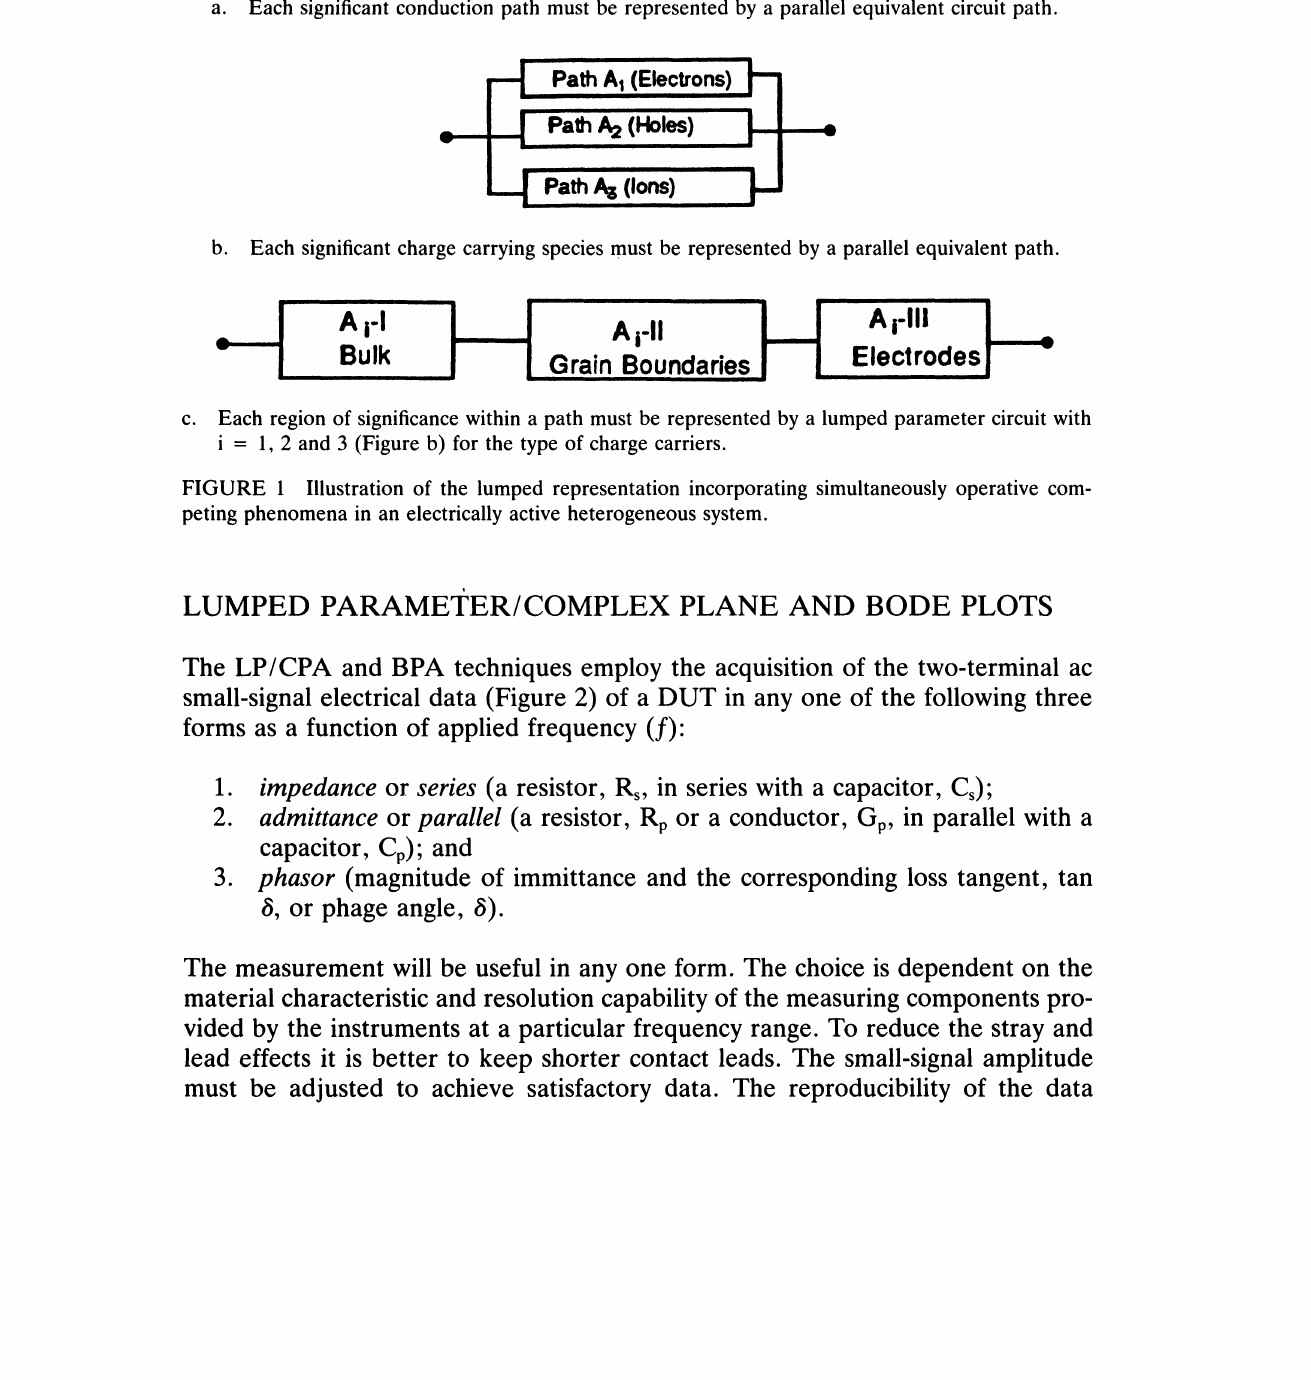
Path, A (Electrons) Path A (Ions) b. Each significant charge carrying species must be represented by a parallel equivalent path. At-I Ai’lll Ai’ll Electrodes Bulk Grain Boundaries c. Each region of significance within a path must be represented by a lumped parameter circuit with 1, 2 and 3 (Figure b) for the type of charge carriers. FIGURE Illustration of the lumped representation incorporating simultaneously operative com- peting phenomena in an electrically active heterogeneous